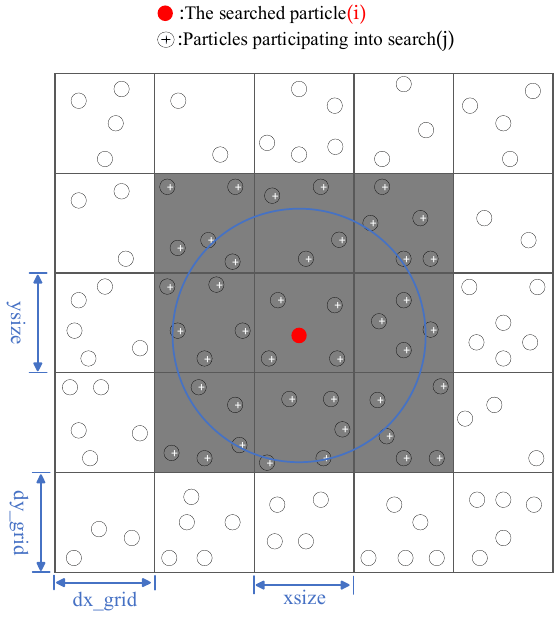
Figure 5. Framework of particle search [81].